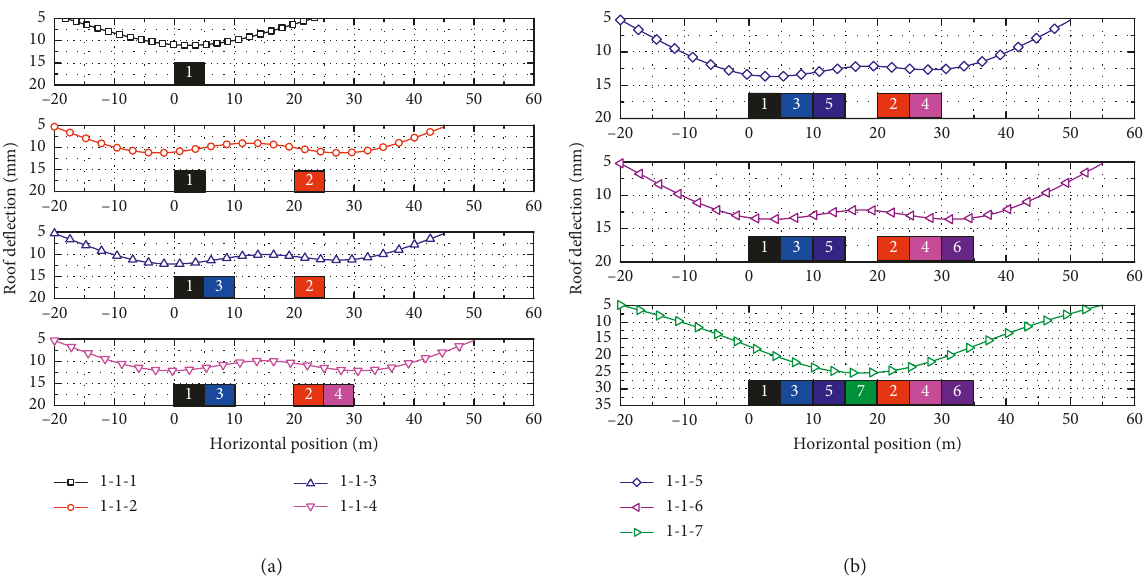
Figure 6: Deflection curves of the roof in the first mining cycle of the first slice. (a) 1-1-1 ∼ 1-1-4 mining step and (b) 1-1-5 ∼ 1-1-7 mining